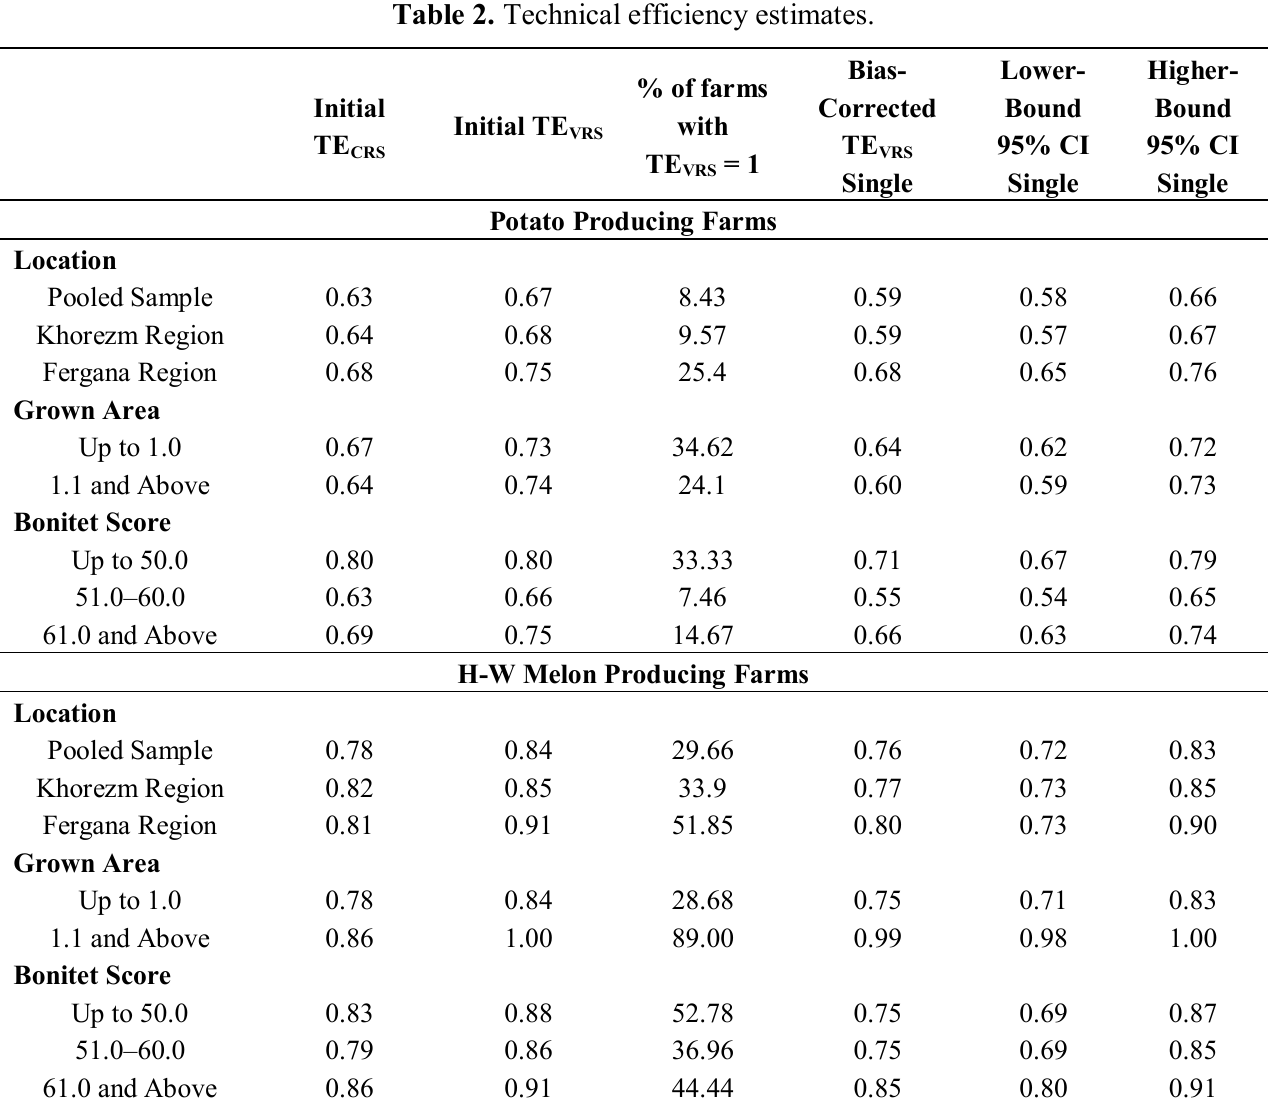
Table 2. Technical efficiency